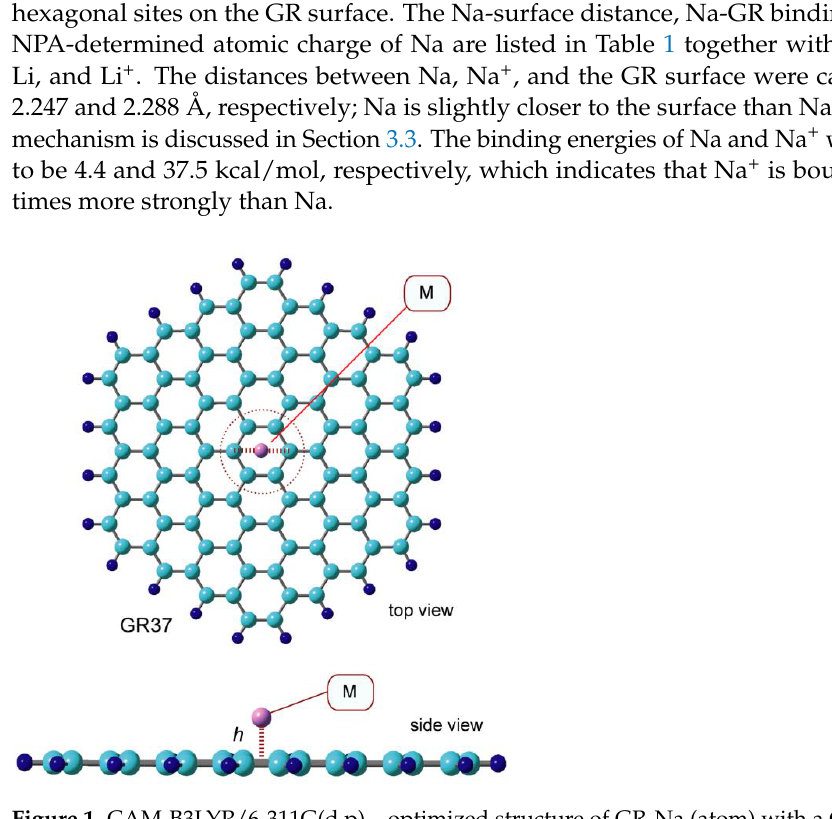
Figure 1. CAM-B3LYP/6-311G(d,p)—optimized structure of GR-Na (atom) with a GR composed of 37 benzene rings.